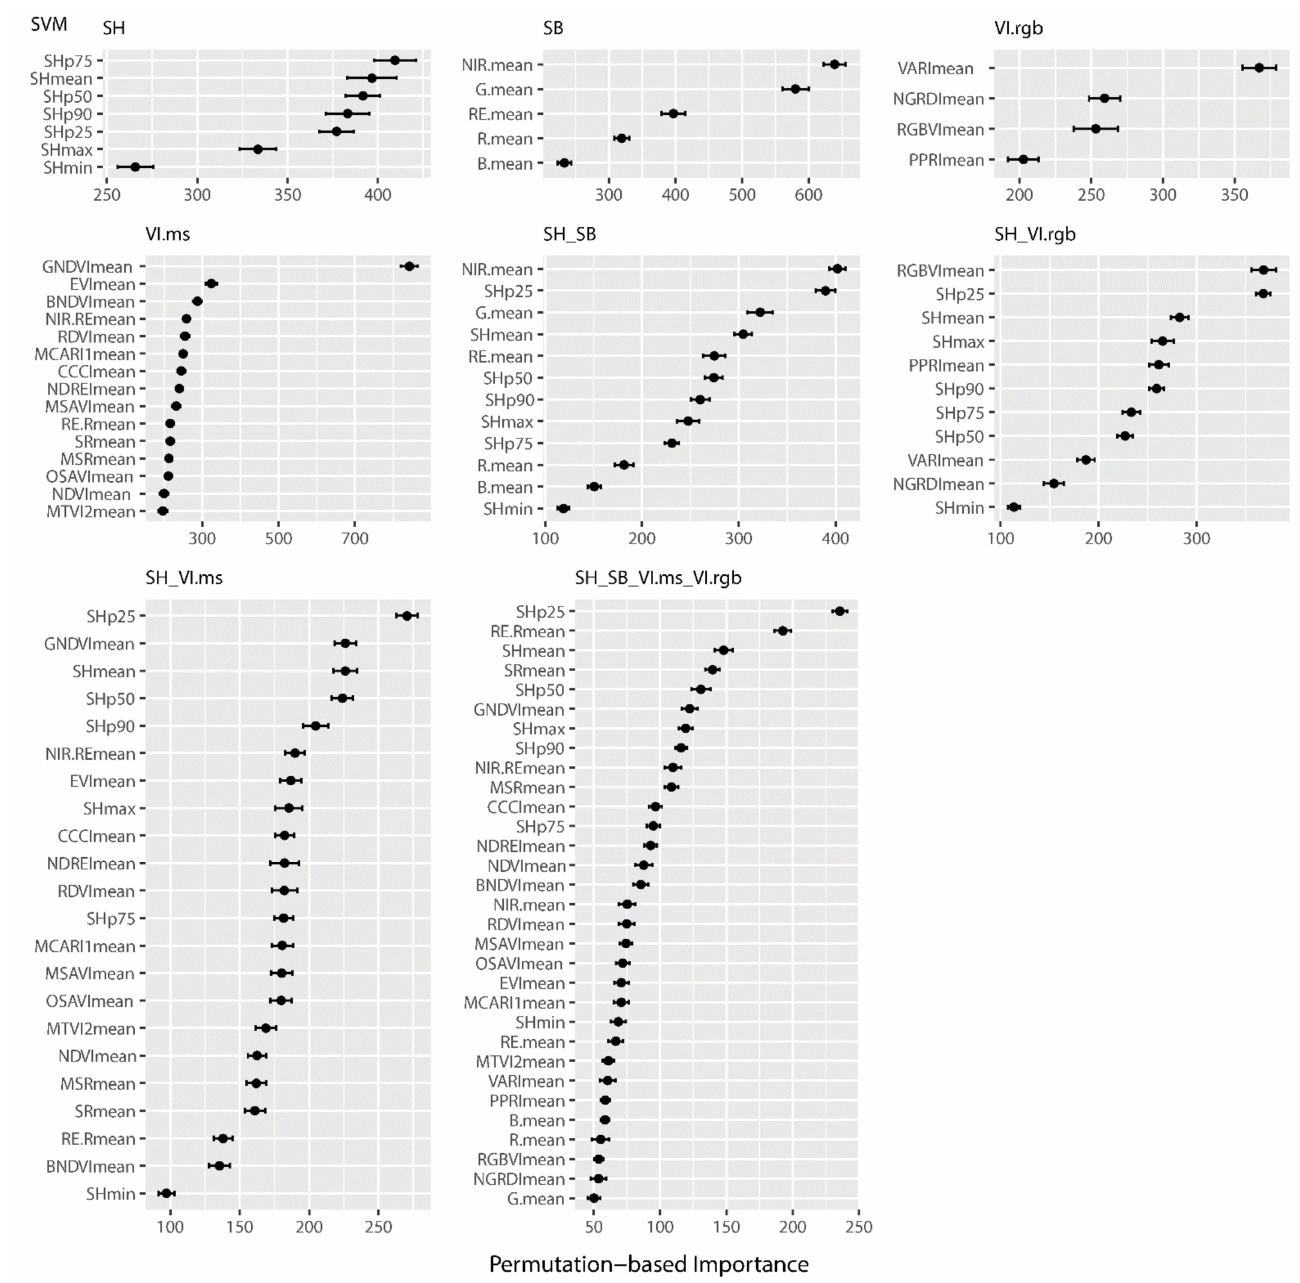
Figure A3. VIP of DMY estimation with